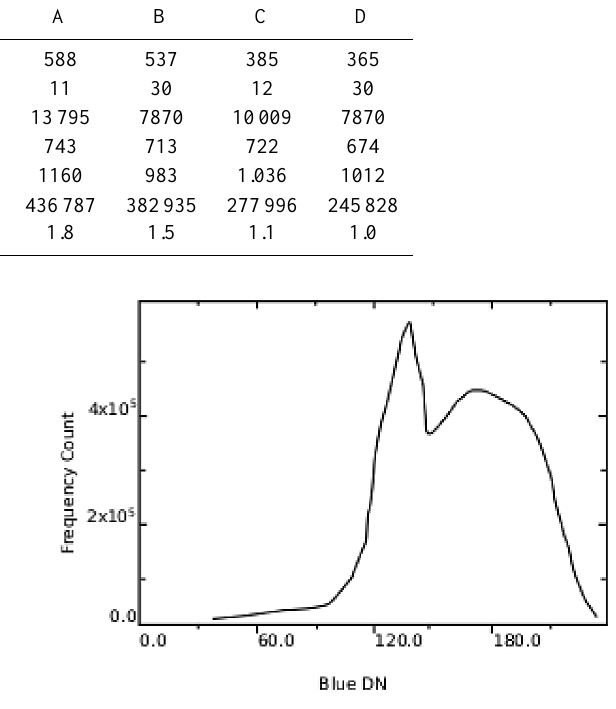
Figure 4. Frequency distribution of the digital number (DN) values of the WorldView-2 satellite image in the blue